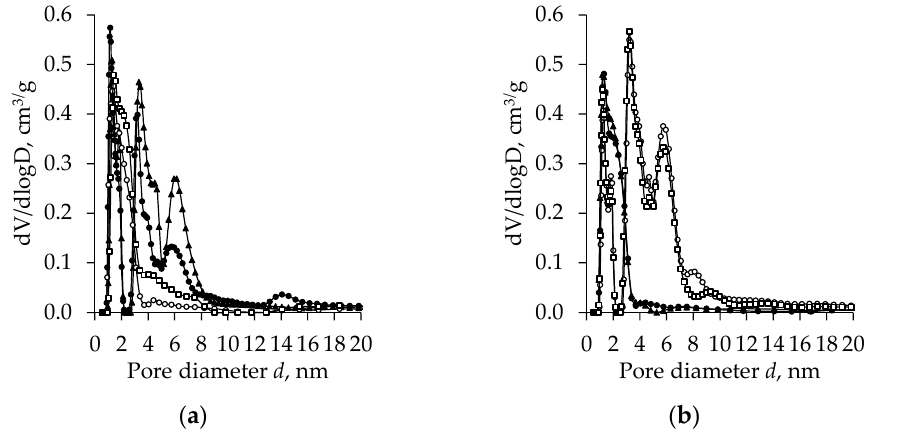
Figure 2. The pore size distribution of subcritical dried (800 mbar, 70 °C, 8 h) TiO 2 aerogels synthe- sized using the TBOT precursor versus the type of exchange solvent ( ● —without exchange, ○ —nH, ▲ —CH, □ —DE) and ageing (without ( a ) and after ( b ) ageing).